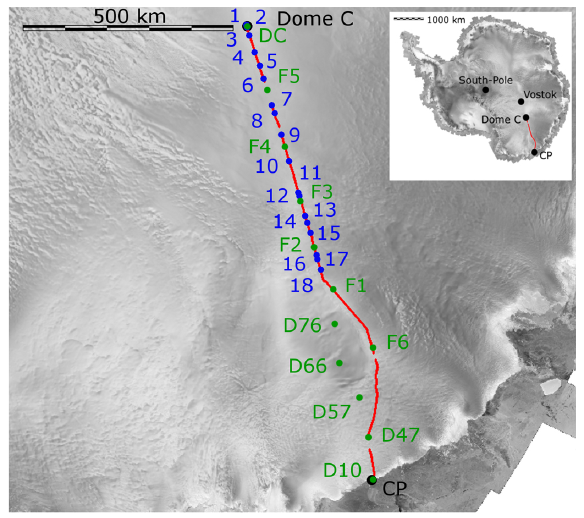
Fig. 1. Map of Antarctica showing the location of the radar sec- tion analysed (numbered 1 to 18, in blue) and cores (in green). Each blue number corresponds to the beginning of a radargram. A general map of Antarctica is inserted in the top right corner to show the location of the main scientific stations on the Antarctic plateau and East Antarctica, as well as the transect between DC and Dumont-d’Urville (Cap Prud’Homme is indicated on the map instead of Dumont-d’Urville, the latter being located on an island 5km